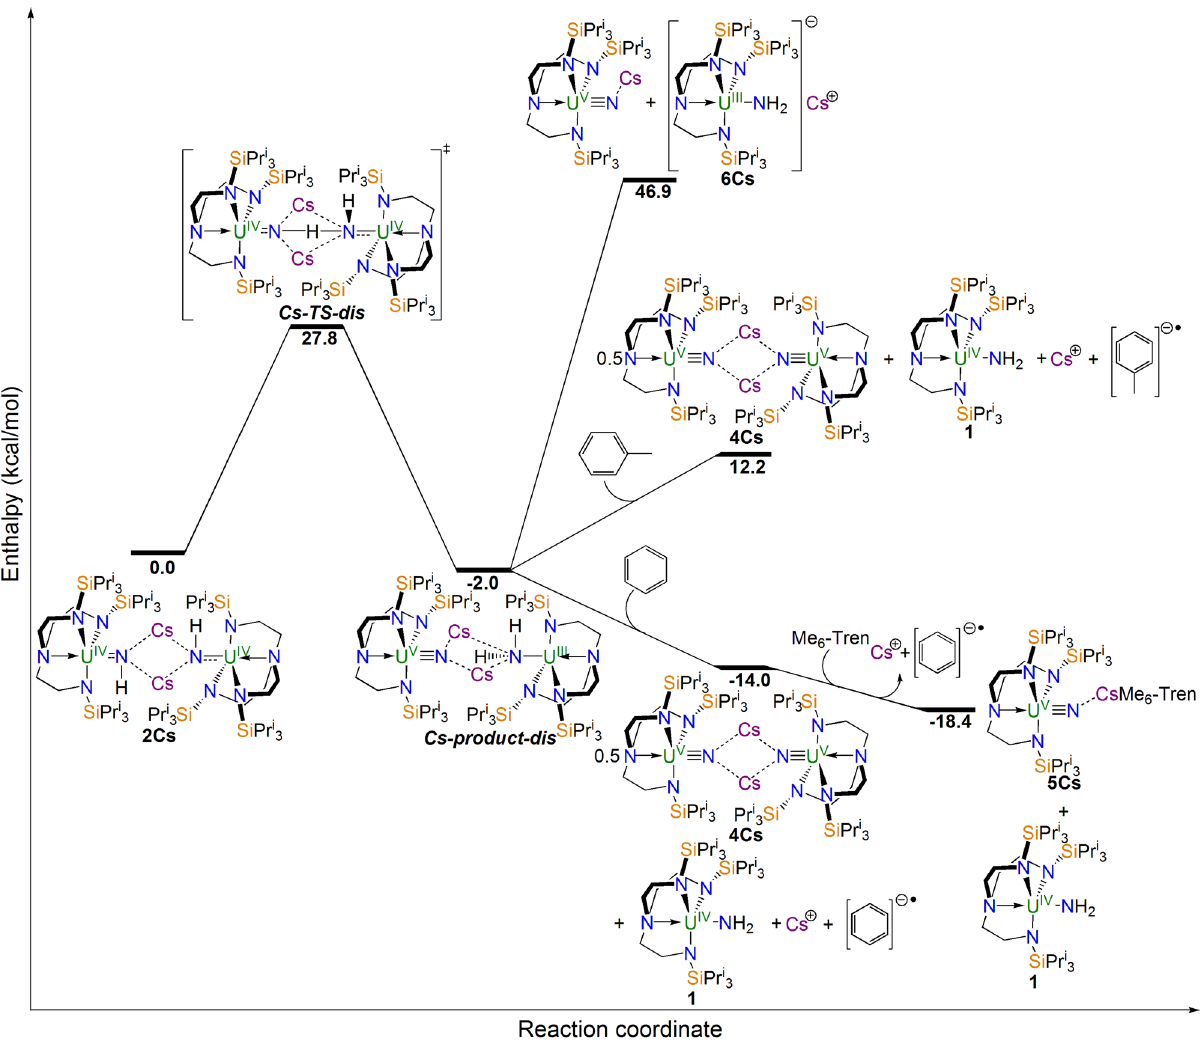
Fig. 7 Computed reaction pro fi le for the disproportionation of 2Cs to 4Cs/1/Cs + (C 6 H 6 ) − (cid:129) . Complex 2Cs containing two uranium(IV) ions reacts via transition state Cs-TS-dis to give the disproportionation intermediate Cs-product-dis where uranium(V) and (III) ions are formed. Spontaneous cleavage of Cs-product-dis to two monomer units is clearly disfavoured, as is reaction with toluene to give 4Cs , 1 , and the caesium toluene radical anion salt. Cs-product-dis however does react with benzene to give 4Cs , 1 , and the caesium benzene radical anion salt. Complex 4Cs is then converted to 5Cs using the capping agent Me 6